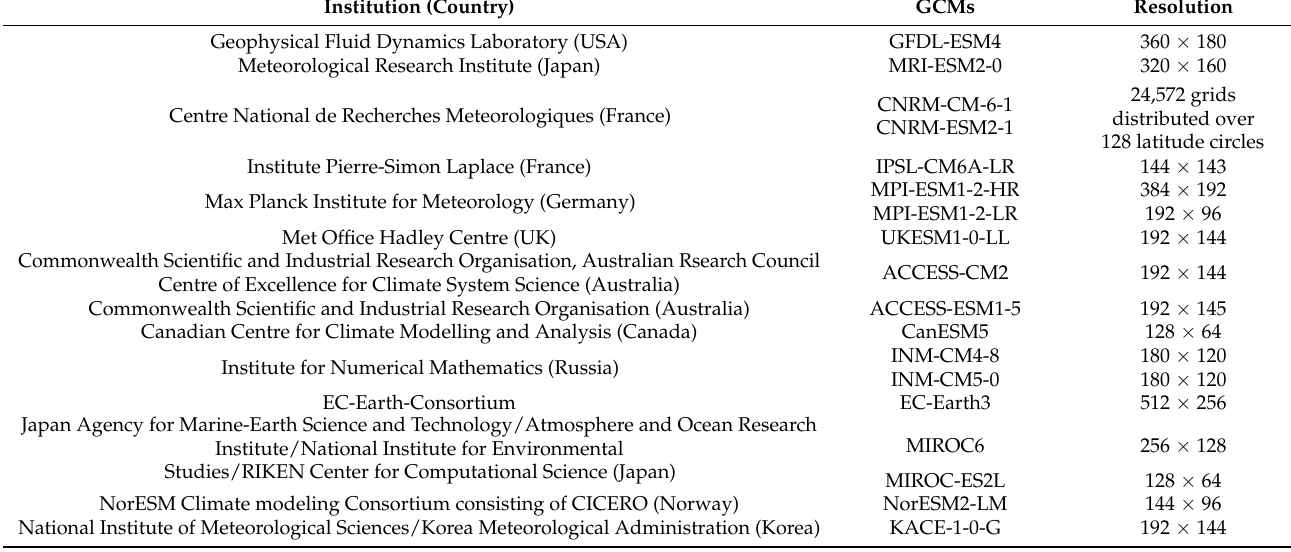
Table A1. CMIP6 GCM lists